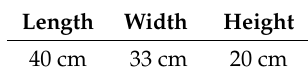
Table 1. Dimensions of the metal box, which was regarded as the target in the experiment.